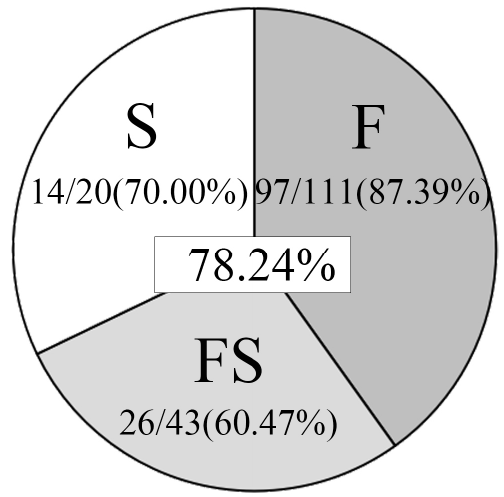
Figure 6. Discrimination results based on deformation.